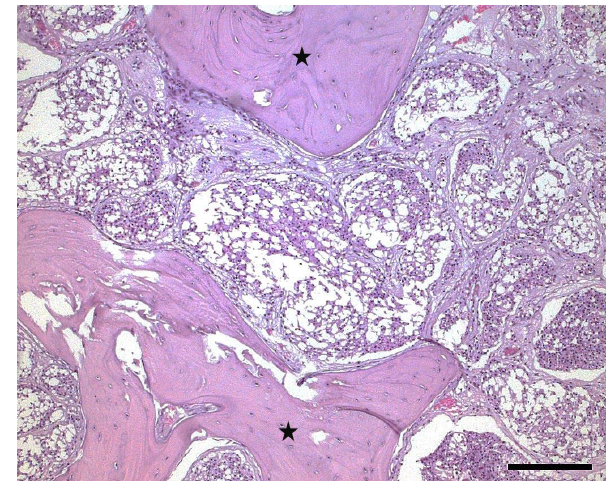
Figure 4. Histological photograph of a meningioma in an old pig- tailed macaque: Microcystic part of the meningioma characterized by vacuolated tumor cells. (hematoxylin–eosin, scale bar = 200µm; asterisks: